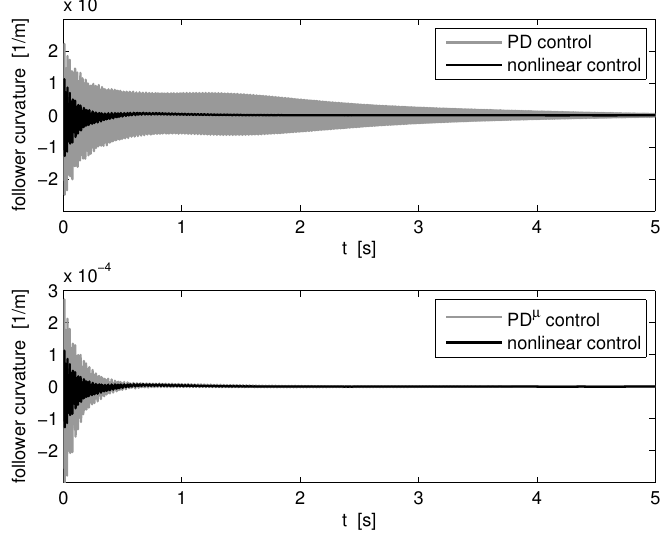
Figure 6. Curvature of the follower, comparison with PD and PD µ